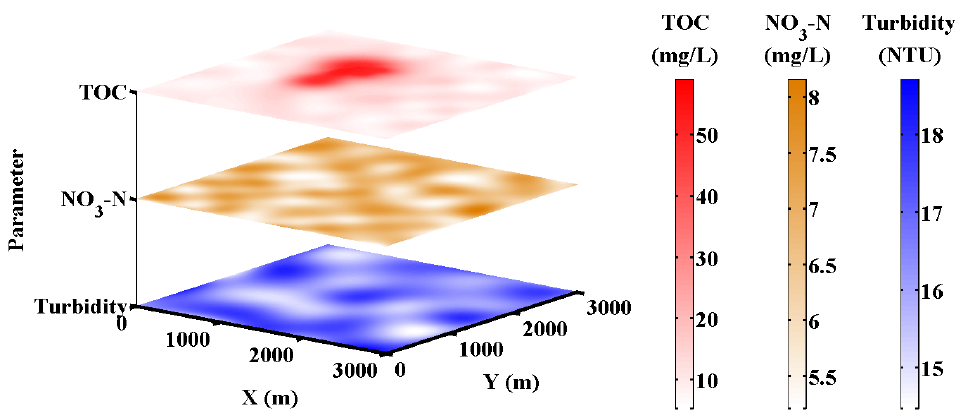
Figure 9. The simulated water quality multi-parameter distribution.